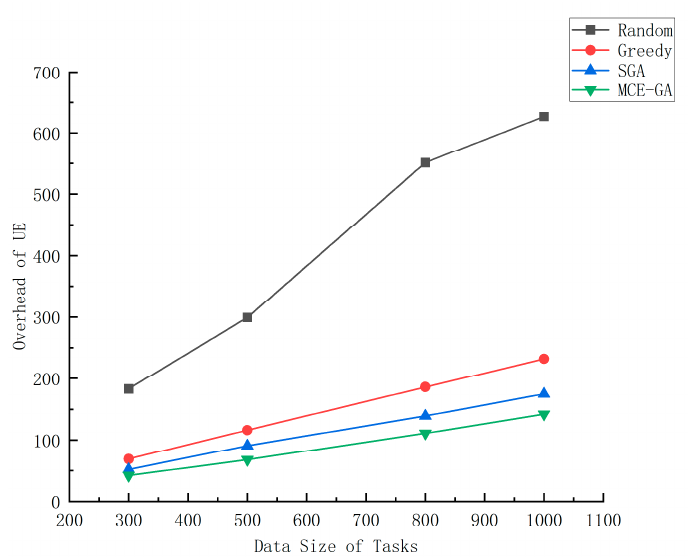
Figure 9. The execution overhead of different data size of tasks.